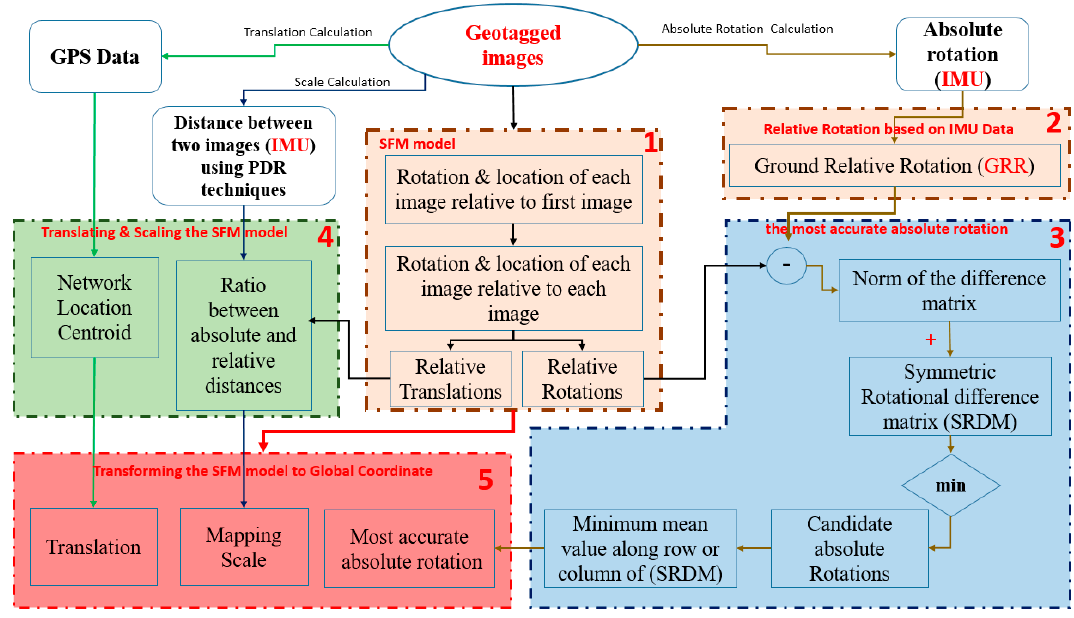
Figure 3. Methodology Workflow.